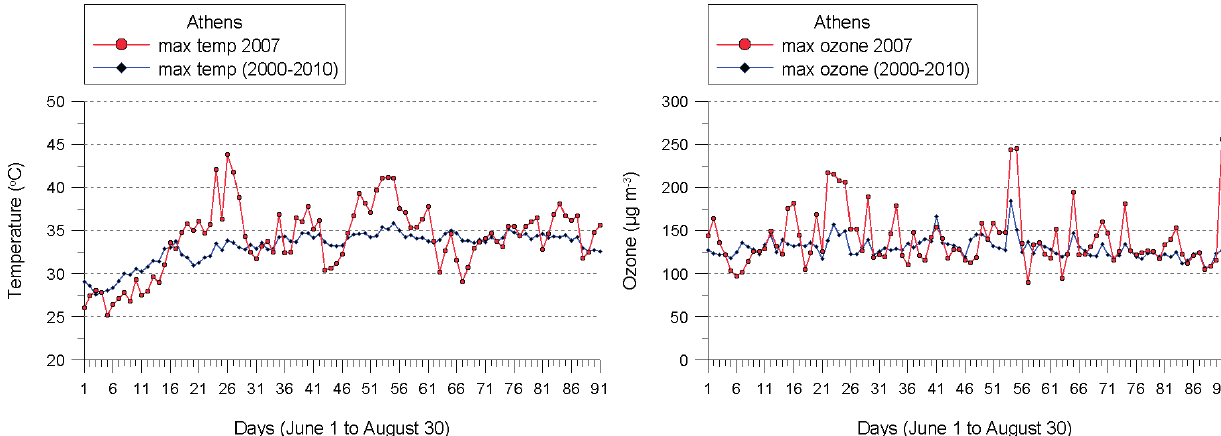
Figure 2. Observed maximum diurnal temperatures (red left ) and ozone levels (red right ) during the summer months (1 June to 30 August) of 2007, compared to average diurnal maximum for the period 2000 to 2010.